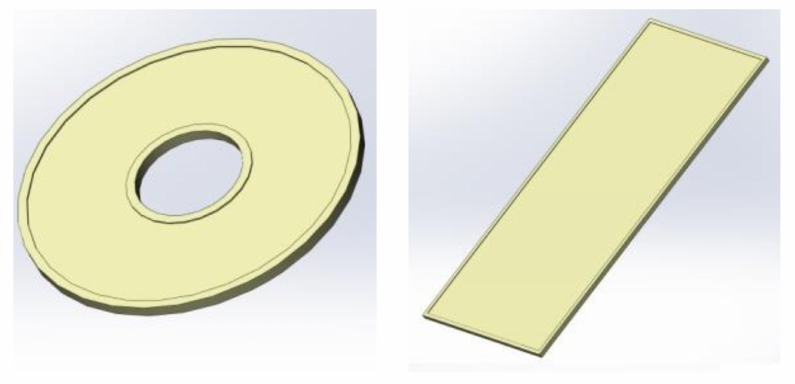
Figure 2. The most commonly used piezoelectric transducer